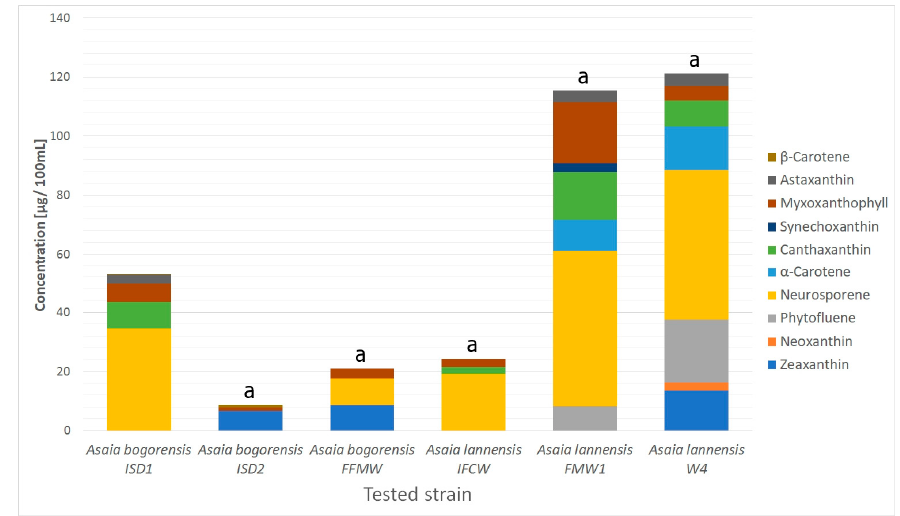
Figure 2. Profiles of carotenoids produced by Asaia spp. Values are statistically different ( p < 0.05). a: p < 0.005. The results were compared to those received for Asaia bogorensis ISD1.